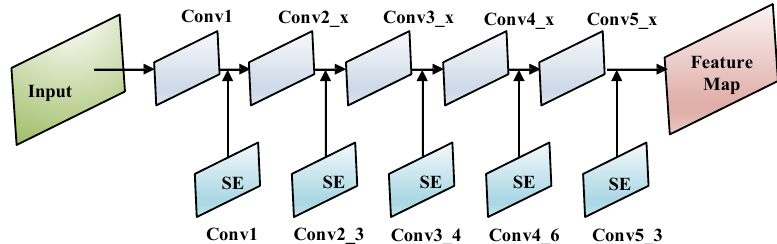
Figure 8. Resnet-50 embedded SENet .